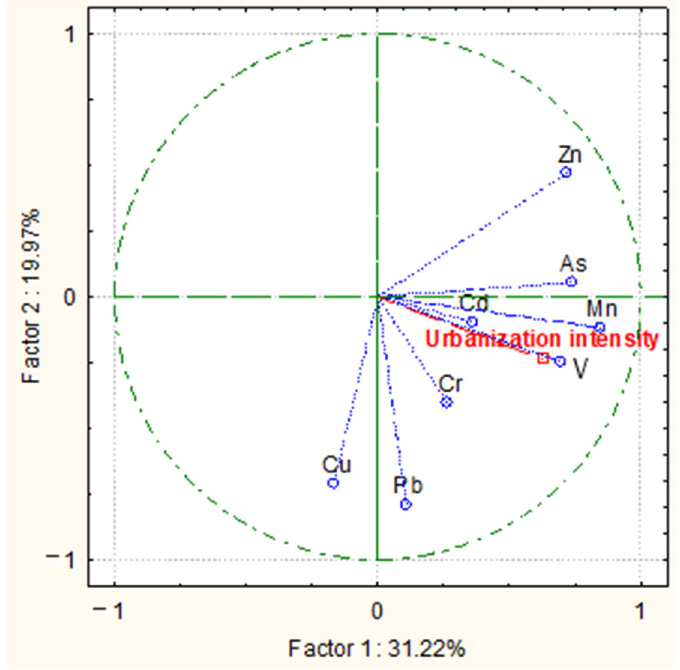
Figure 2. Bi-plot graph resulting from principal component analysis (PCA) illustrating the correlation between measured variables (content of potentially toxic elements in tree leaves) and urbanization intensity. Table 5. Leaf traits at August 2020—6 years after transplantation into the urban